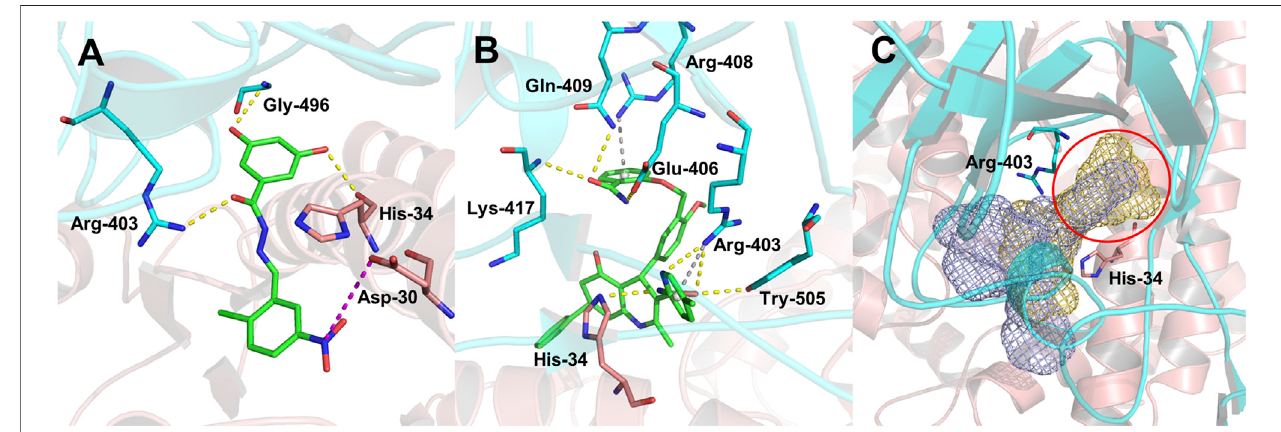
FIGURE 6 | Analysis of binding modes of DC-RA016 and DC-RA052. (A) The lowest energy docked poses of DC-RA016 on the SARS-CoV-2 S-RBD/ACE2 interface. (B) The lowest energy docked poses of DC-RA052 on the SARS-CoV-2 S-RBD/ACE2 interface. (C) Superimposition of the docked poses of DC-RA016 and DC-RA052 (yellow and purple mesh). The green sticks denote ligands, the critical residues in binding cavities are shown as blue sticks (S-RBD) and pink sticks (ACE2), and the overall protein structures are shown as a blue cartoon (S-RBD) and a pink cartoon